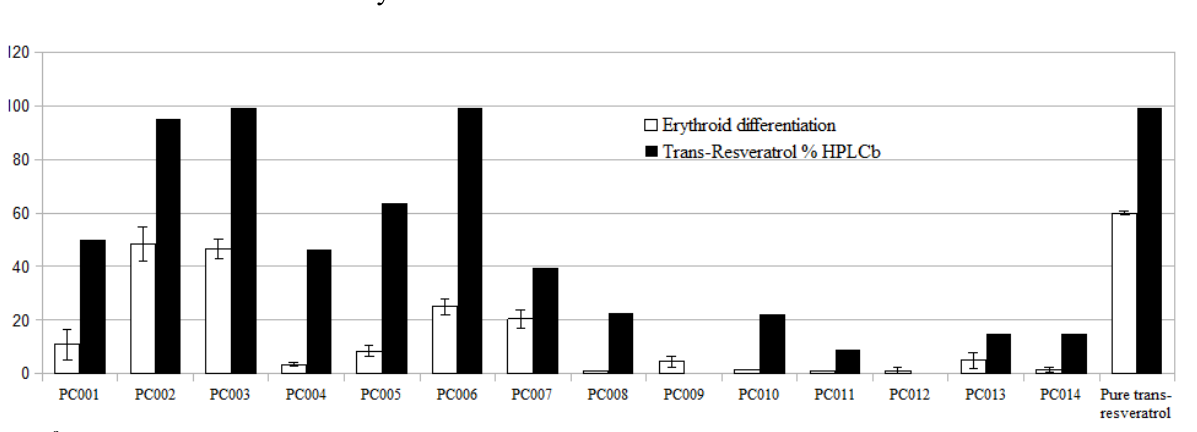
Figure 2. Effect of trans -resveratrol commercial products (10 µg/mL) on erythroid differentiation of human erythroleukemic K562 Cells a